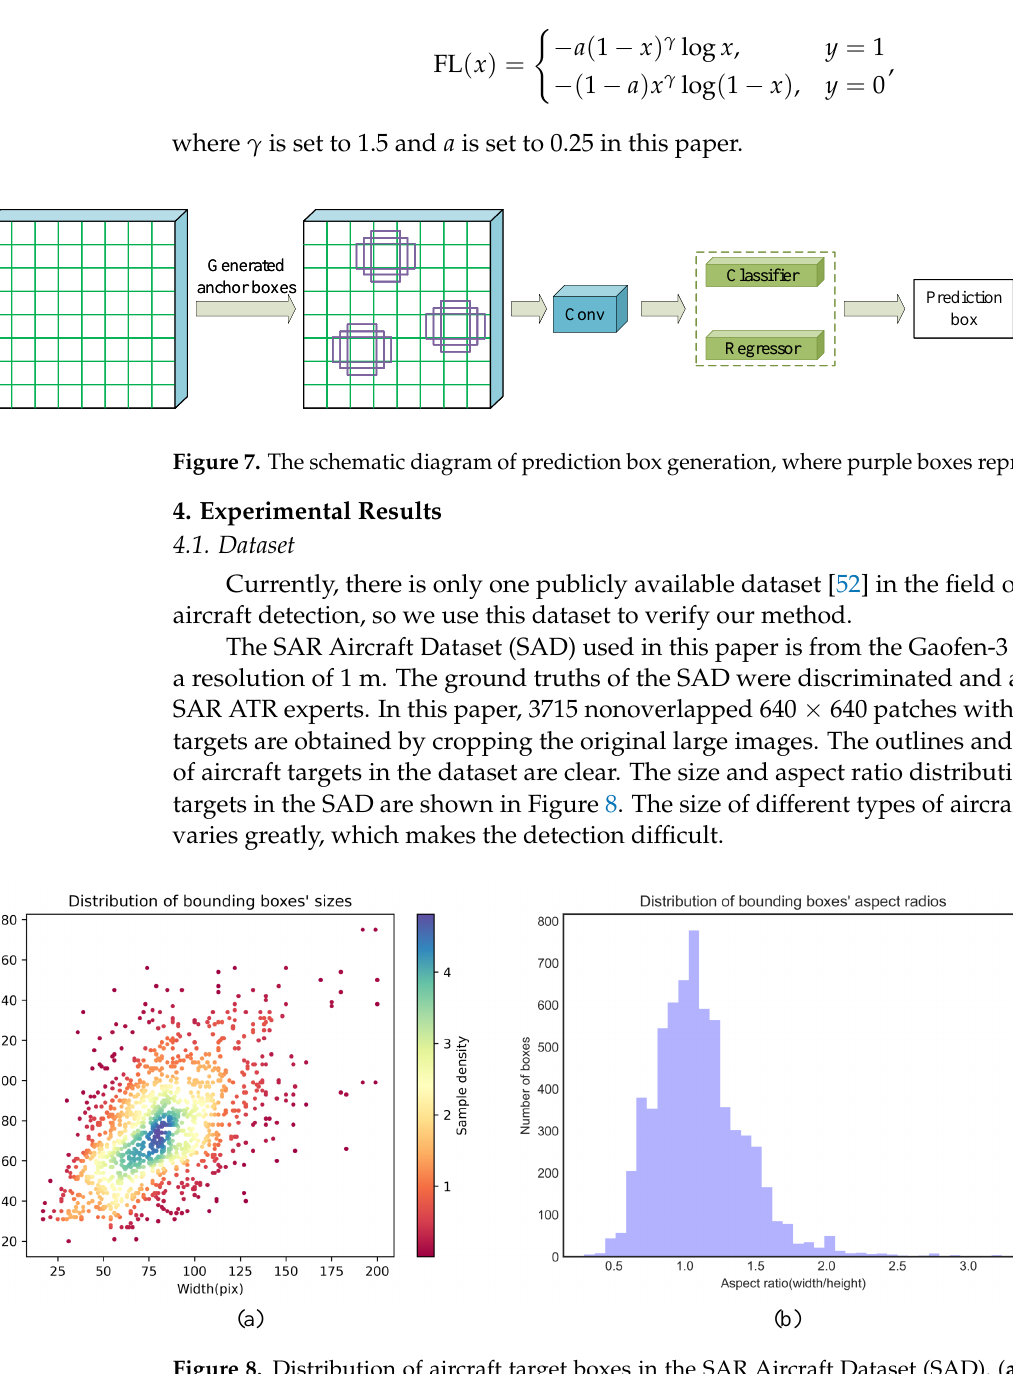
Figure 8. Distribution of aircraft target boxes in the SAR Aircraft Dataset (SAD). ( a ) Aircraft size distribution. ( b ) Aircraft aspect ratio